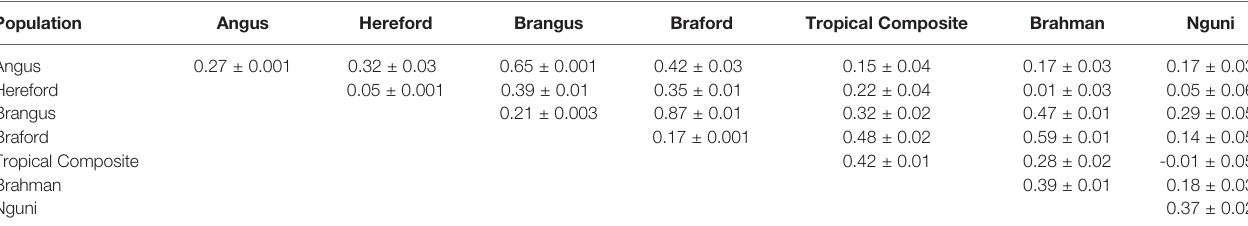
TABLE 3 | Posterior mean and time series standard errors for genetic correlations (above diagonal) and heritabilities (diagonal) of tick resistance measures across different populations. Population